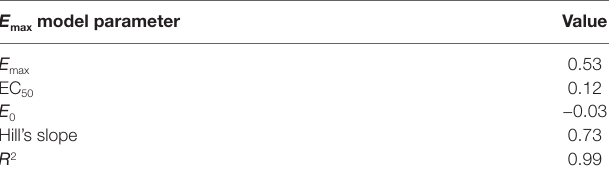
Table 2 . The relative errors of absorption half-life and elimination